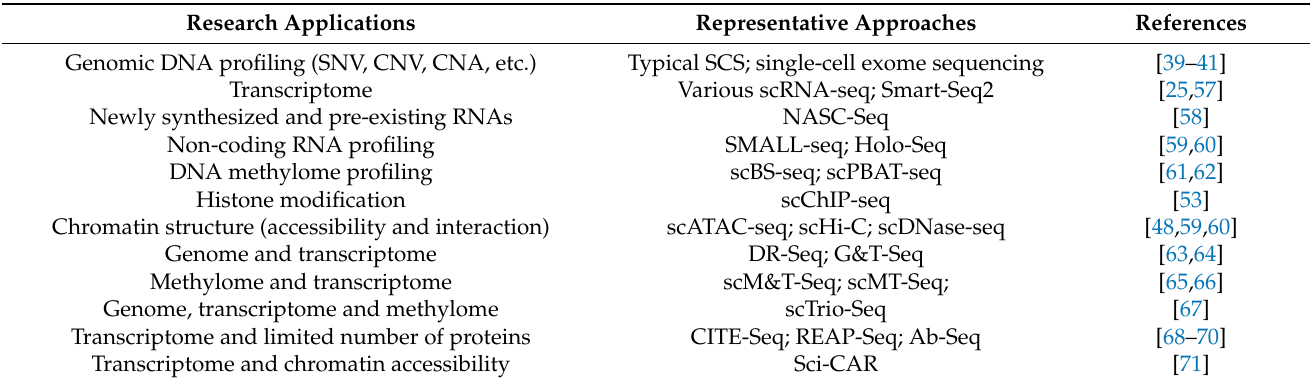
Table 1. Summary of major types of SCS approaches used in current research